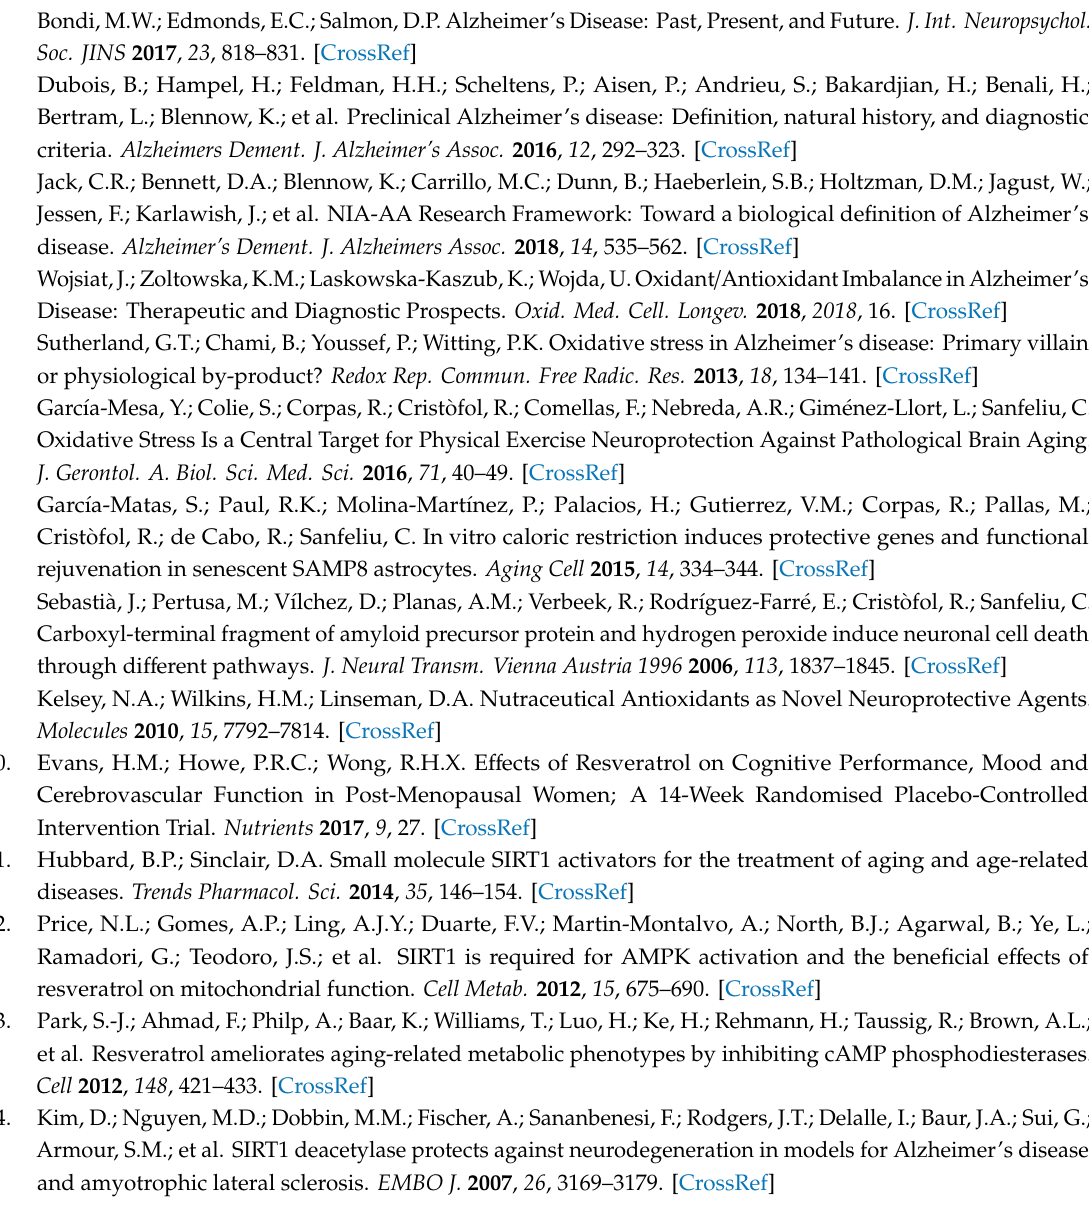
Table S1: List of primers and probe sets used for real time RT-PCR